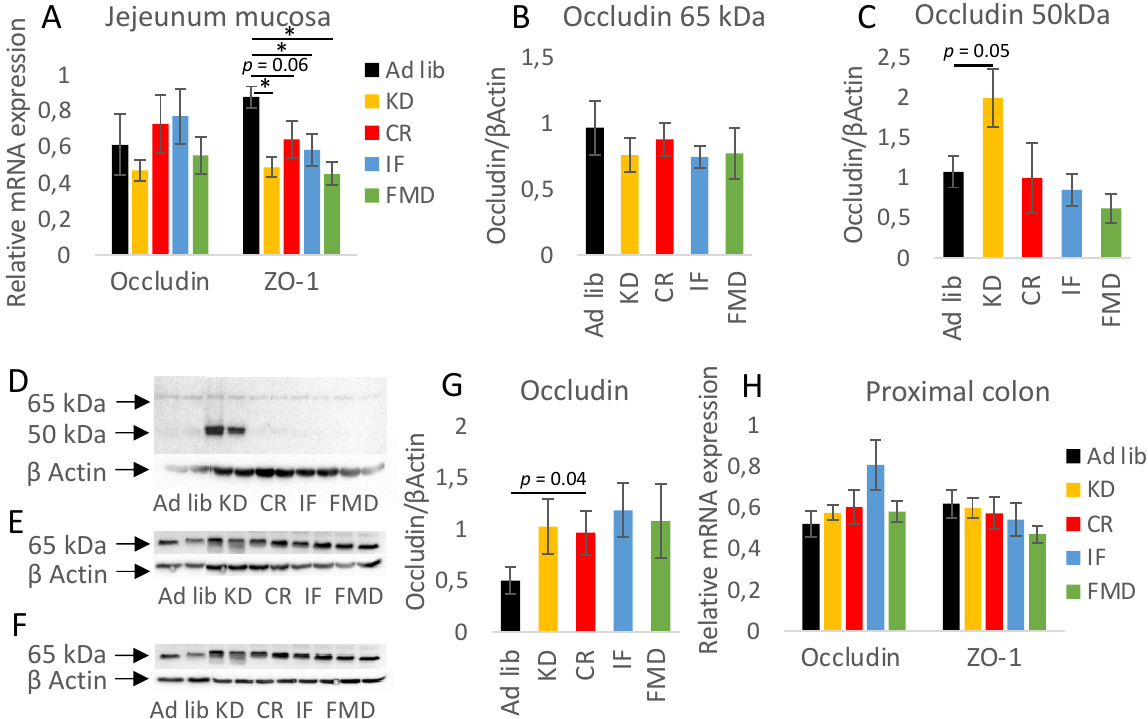
Figure 6. KD induces the occurrence of the truncated form of occludin. The relative mRNA level of zonulin (ZO-1) was measured in the mucosa of the jejunum ( A ) and proximal colon ( H ). The expres- sion of occludin was quantified on the mRNA ( A , H ) and protein ( B – G ) levels in the mucosa of the jejunum ( A – D ) and proximal colon ( E – G ). Statistical significance between experimental groups was evaluated using ANOVA and Tukey’s post hoc test. * p < 0.01; n = 6–8.